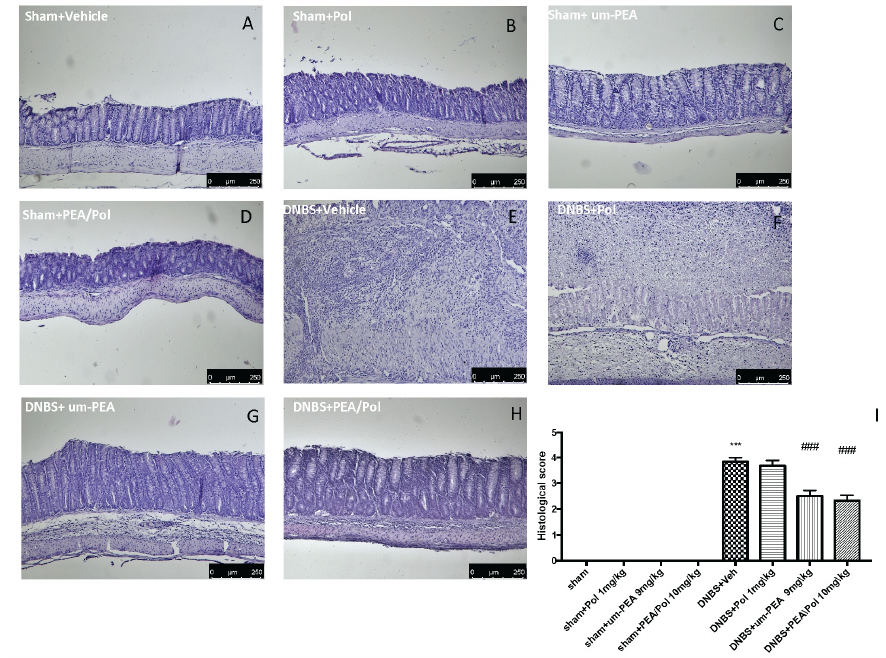
Figure 2. The effects of PEA/Pol on histological damage after DNBS injection. Histological analysis was evaluated in sham ( A ), sham+Pol ( B ), sham+um-PEA ( C ), sham+PEA/Pol ( D ), DNBS+Veh ( E ), DNBS+Pol ( F ), DNBS+um-PEA ( G ), and DNBS+PEA/Pol ( H ). The histological score was measured ( I ). Images are figurative of at least three independent experiments. Values = means ± SEM of six animals in each group; *** p < 0.001 vs. sham; ### p < 0.001 vs. DNBS.